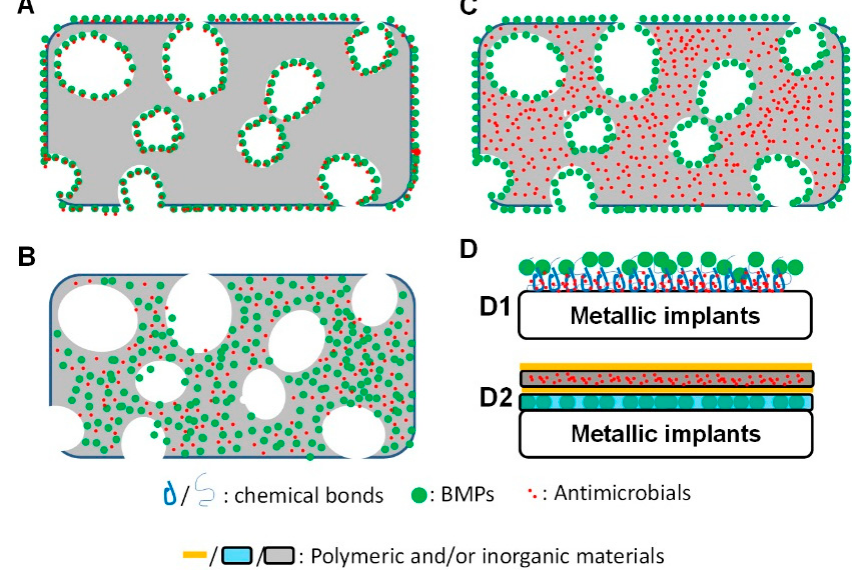
Figure 2. Schematic graph depicting the four different carrying modes of both antibacterial and osteoinductive drugs in biomaterials aiming to treat infected bone defects. ( A ) Superficial adsorption with or without physicochemical bonds; ( B ) A co-encapsulation; ( C ) A mixed carrying mode with encapsulated antibacterial drugs and superficially adsorbed BMPs; ( D ) surface coatings: ( D1 ) both drugs are immobilized by chemical bonds; ( D2 ) both drugs are encapsulated in coating layers with separation layers for a controlled release.